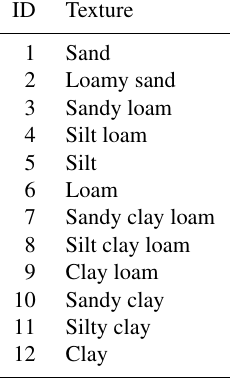
Table A1. Classification of soil texture in ISLSCPII (see Table 1).